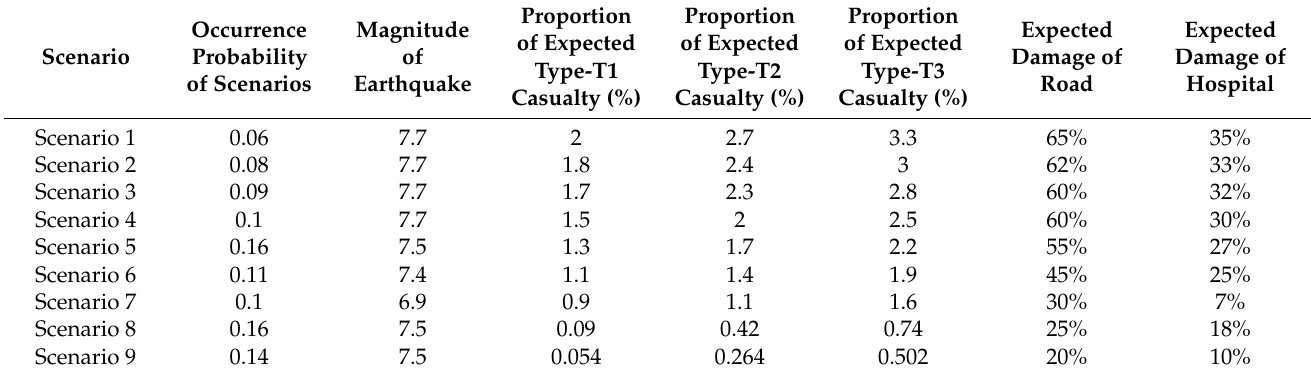
Table 1. The parameters based on the scenario in the case